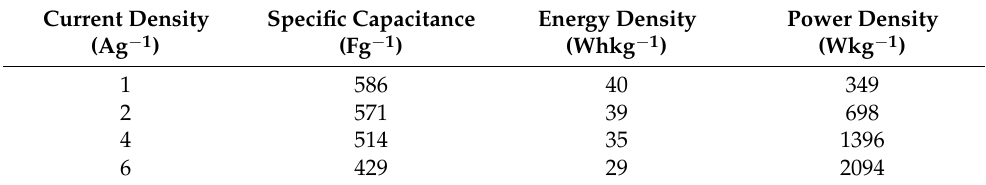
Table 1. Energy density and power density measured for the samples at different values of current density for PANI:PPy/AC composite film deposited on ITO